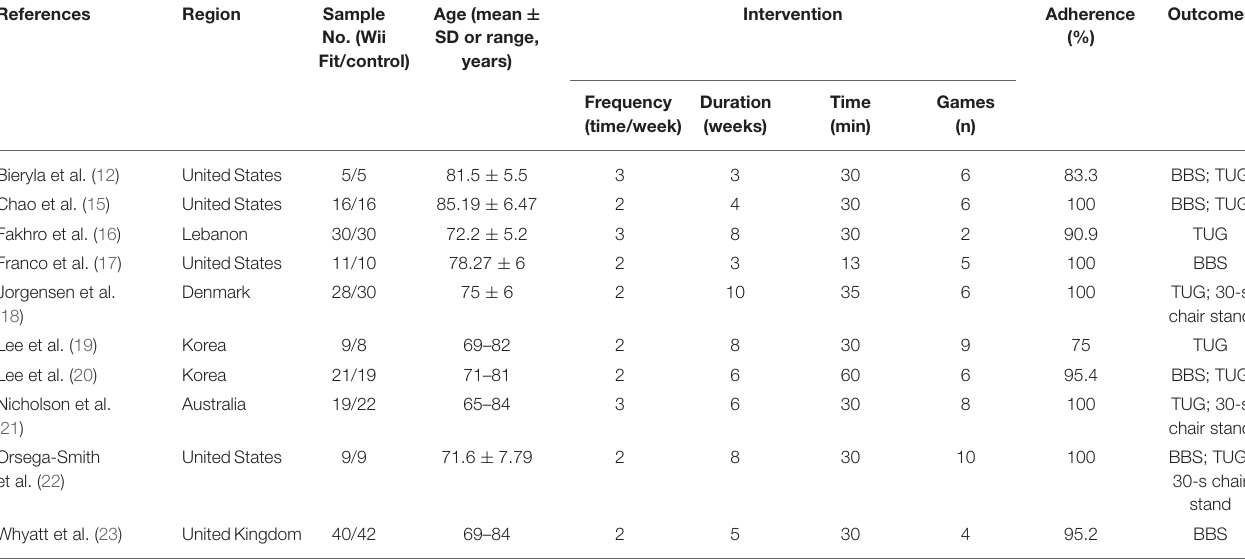
TABLE 1 | Baseline characteristics of included